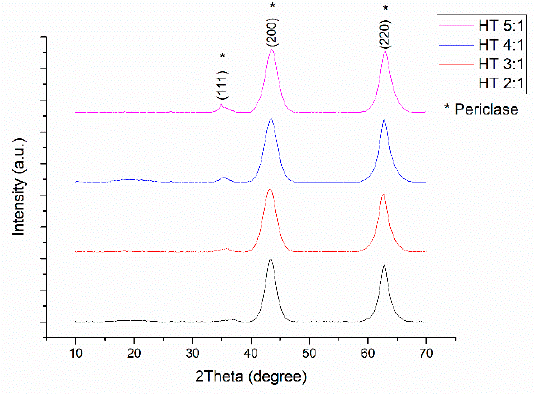
Figure 1. Hydrotalcites X-ray di ff ractograms after calcination of the samples.